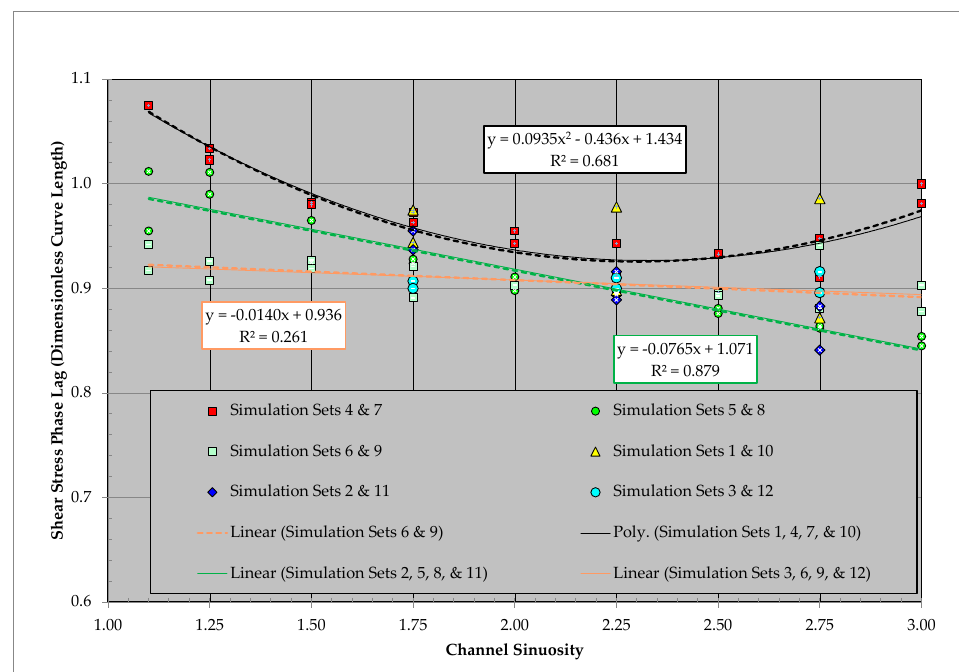
Figure 51. Correlation of dimensionless shear stress phase lag and channel sinuosity using data from all 12 simulation sets.